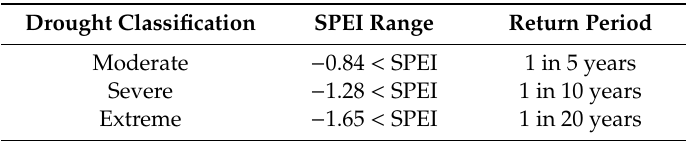
Table 2. Drought classes, and their corresponding range of SPEI (Standardized Precipitation Evapotranspiration Index) values and probability of occurrence, as proposed by Agnew [89] and used in this